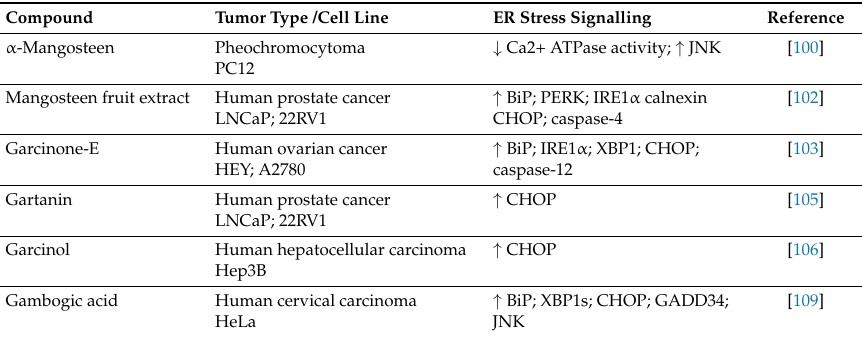
Table 5. Garcinia derivatives with ER stress-mediated anticancer